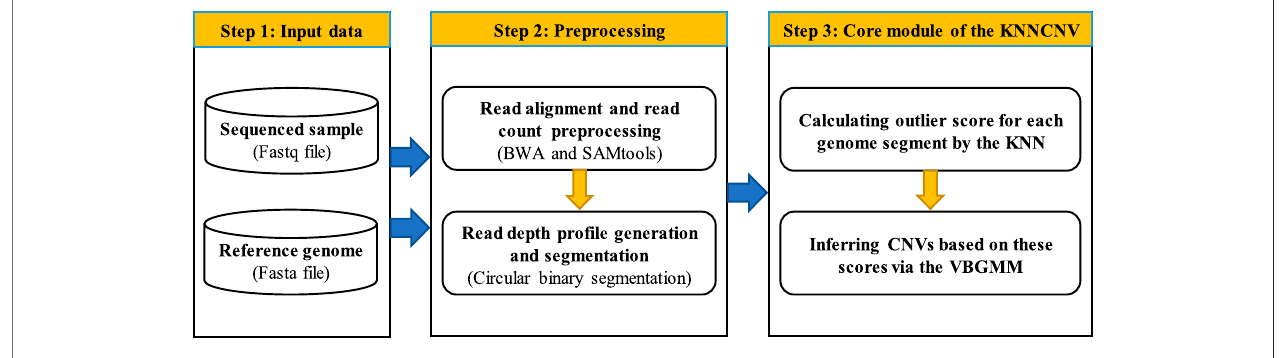
FIGURE 1 | Work fl ow of the KNNCNV